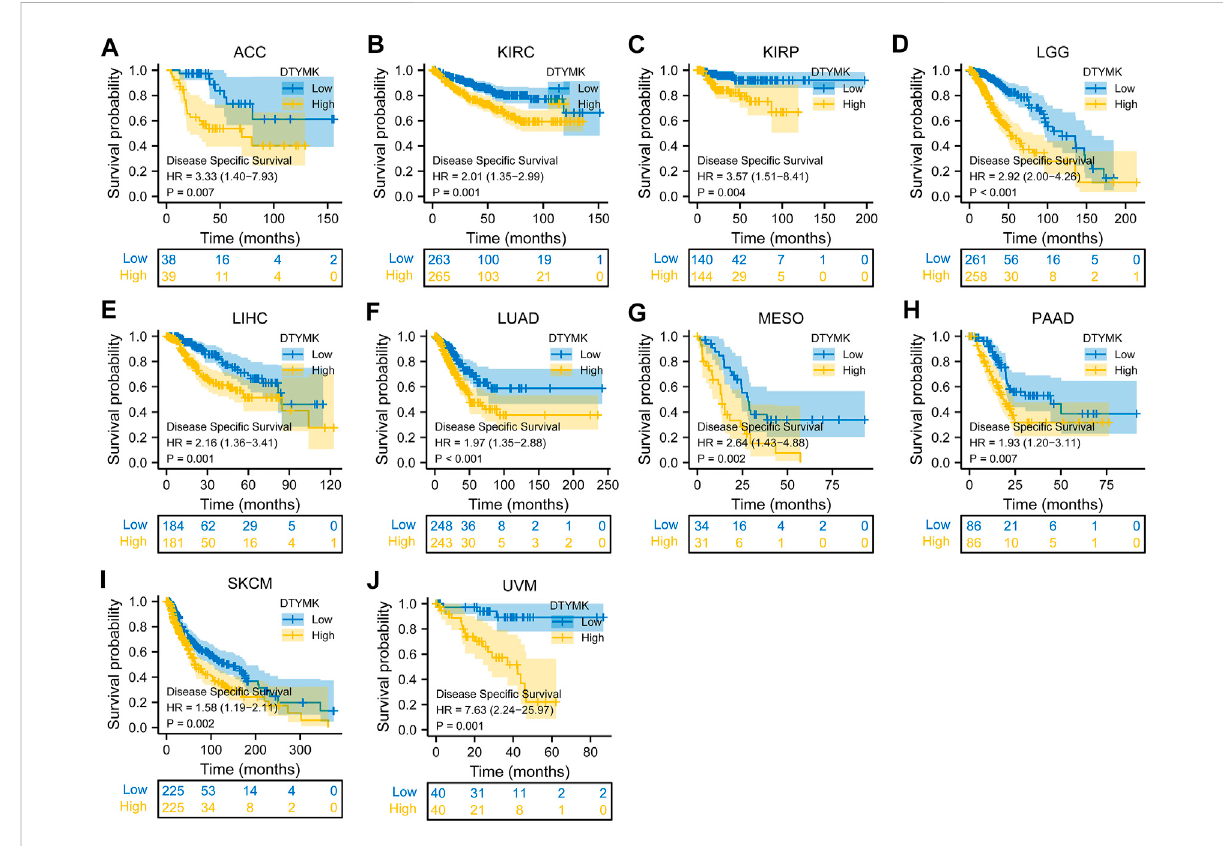
FIGURE 6 Relationship between DTYMK expression and DSS. High DTYMK expression was correlated with short DSS in ACC (A) , KIRC (B) , KIRP (C) , LGG (D) , LIHC (E) , LUAD (F) , MESO (G) , PAAD (H) , SKCM (I) and UVM (J)